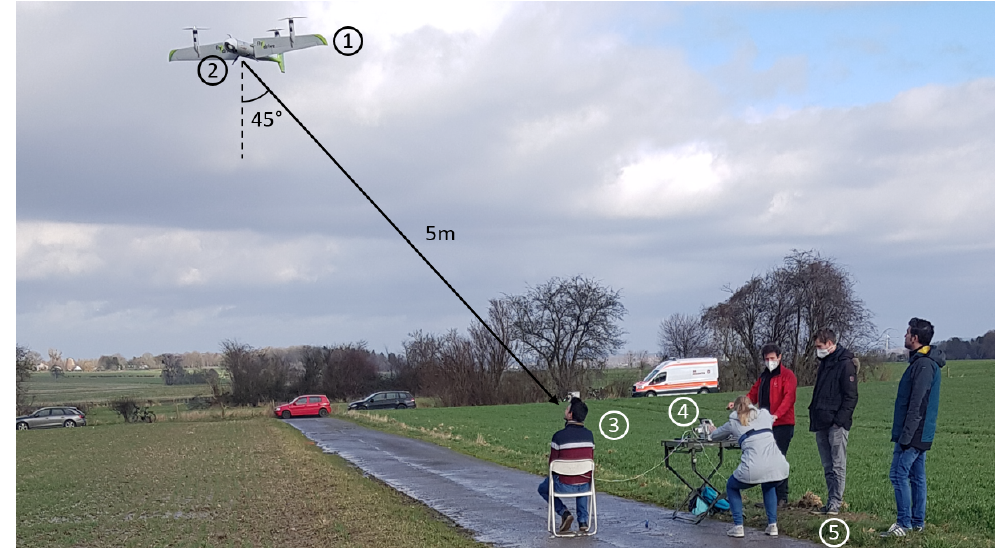
Figure 6. Experimental setup: UAS (1) equipped with gimbal and camera (2) was hovering within a 5 m viewing distance and target engagement angle of 45° of a volunteer subject at a fixed position (3). The reference pleth signal was recorded by a patient monitor and stored on a computer (4). The rest of the respective subject group was preparing for their recordings